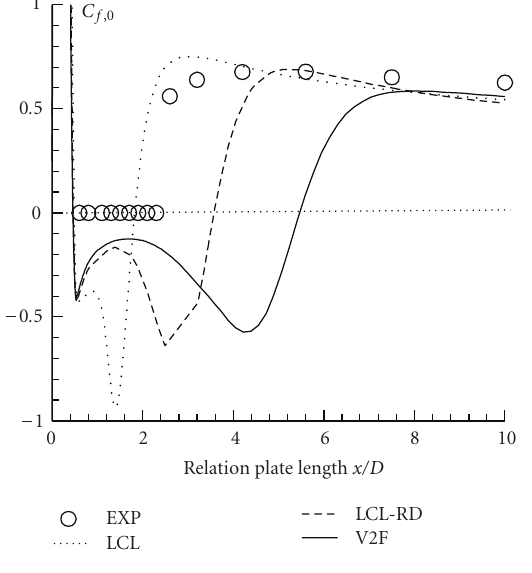
Figure 1: T3L 3 : wall shear stress.